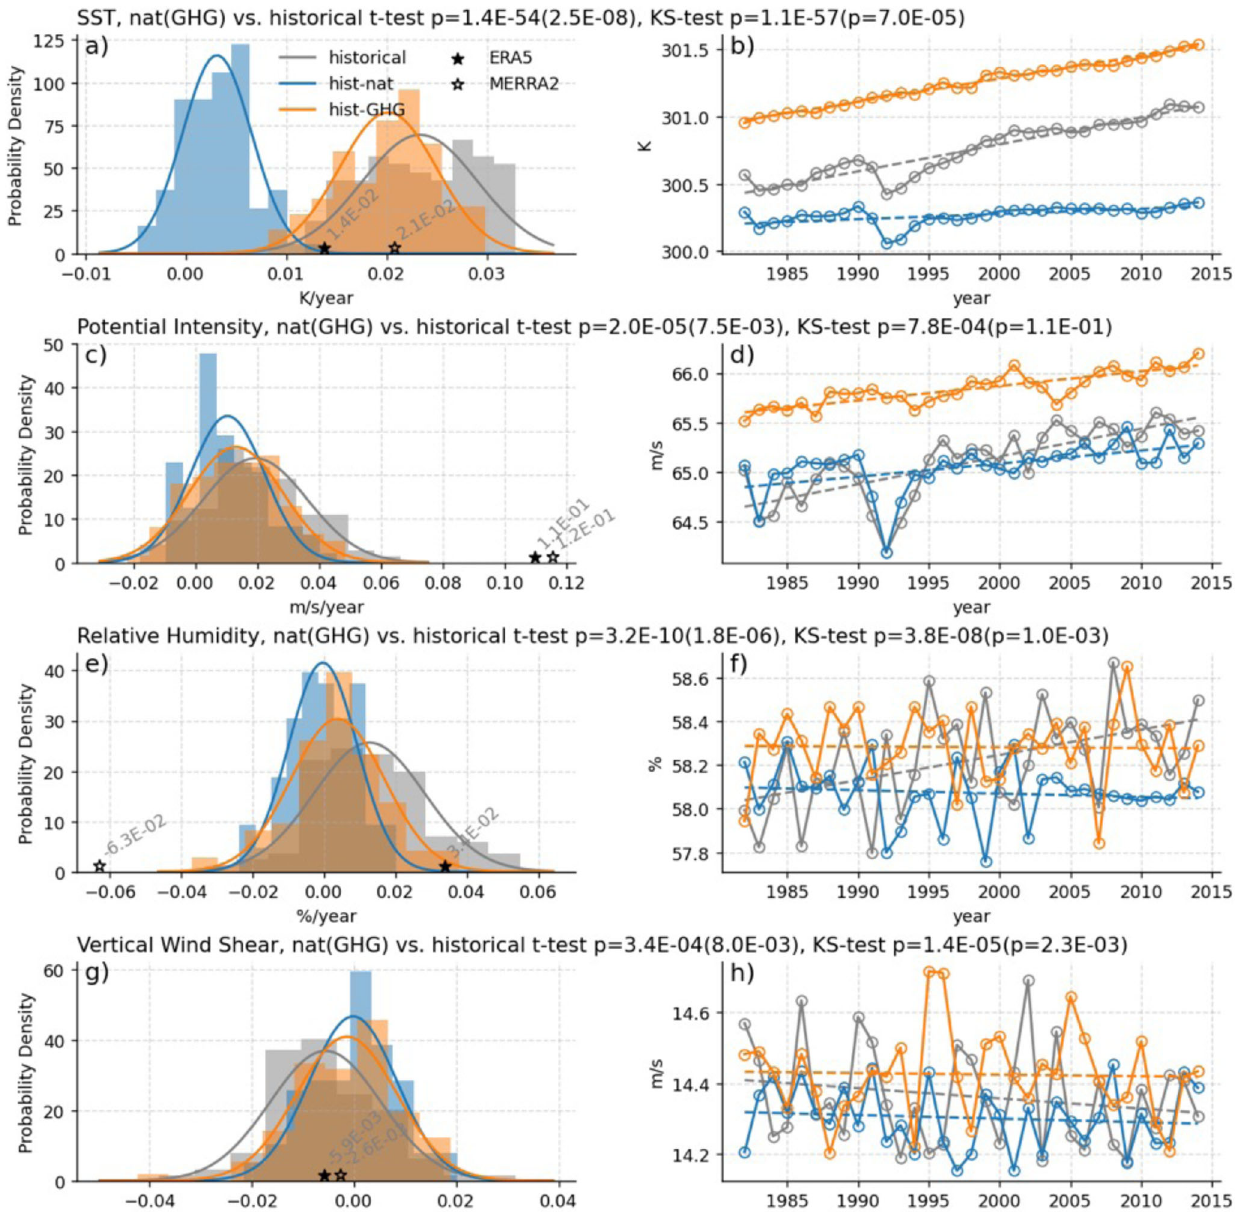
Fig. 6 | Comparing tropical-mean trends in CMIP6 simulations. a – h Observed trends between 1982 − 2014 in tropical-mean sea surface temperature (SST), potential intensity (PI), relative humidity (RH), and vertical wind shear (SHR) for CMIP6 historical (gray), hist-nat (blue), and hist-GHG (orange) simulations. a , c , e , and g show probability distribution functions (pdfs) of the tropical-mean slopes of all the available ensemble members for each simulation type. The pdf curves are calculated using a maximum likelihood estimation of the normal dis- tributionparameters.TheslopesoftheMERRA-2andERA5tropical-meanvaluesfor